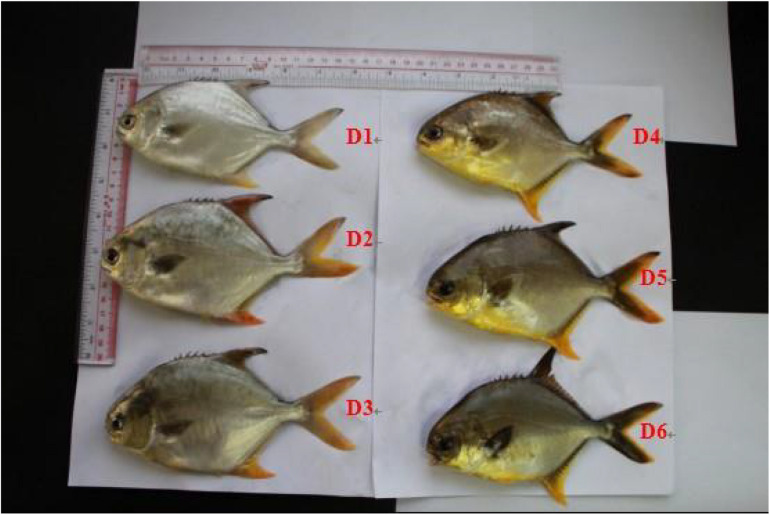
Color of live golden pompano fed the six experimental diets.